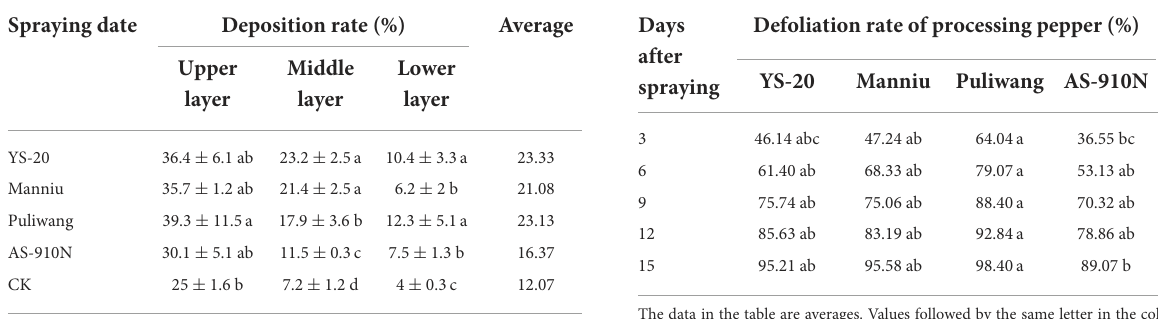
TABLE 5 Effect of aerial spray with adjuvants on the defoliation rate of processing pepper sprayed by